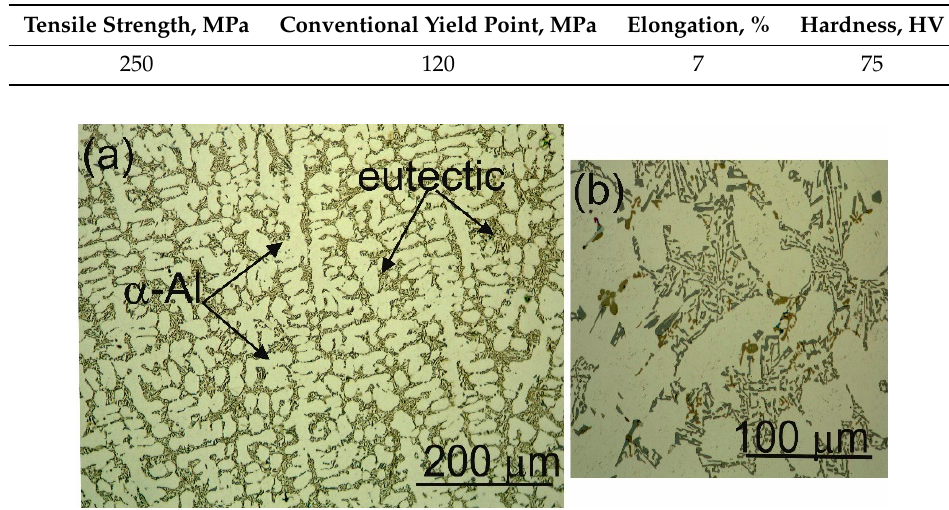
Figure 1. Optical micrographs showing the as-cast microstructure of the Al-Si alloy: ( a ) dendritic structure surrounded by eutectic silicon particles, and ( b ) higher magnification image showing the equiaxed coarse eutectic cell appears in which silicon grows in a modification manner.